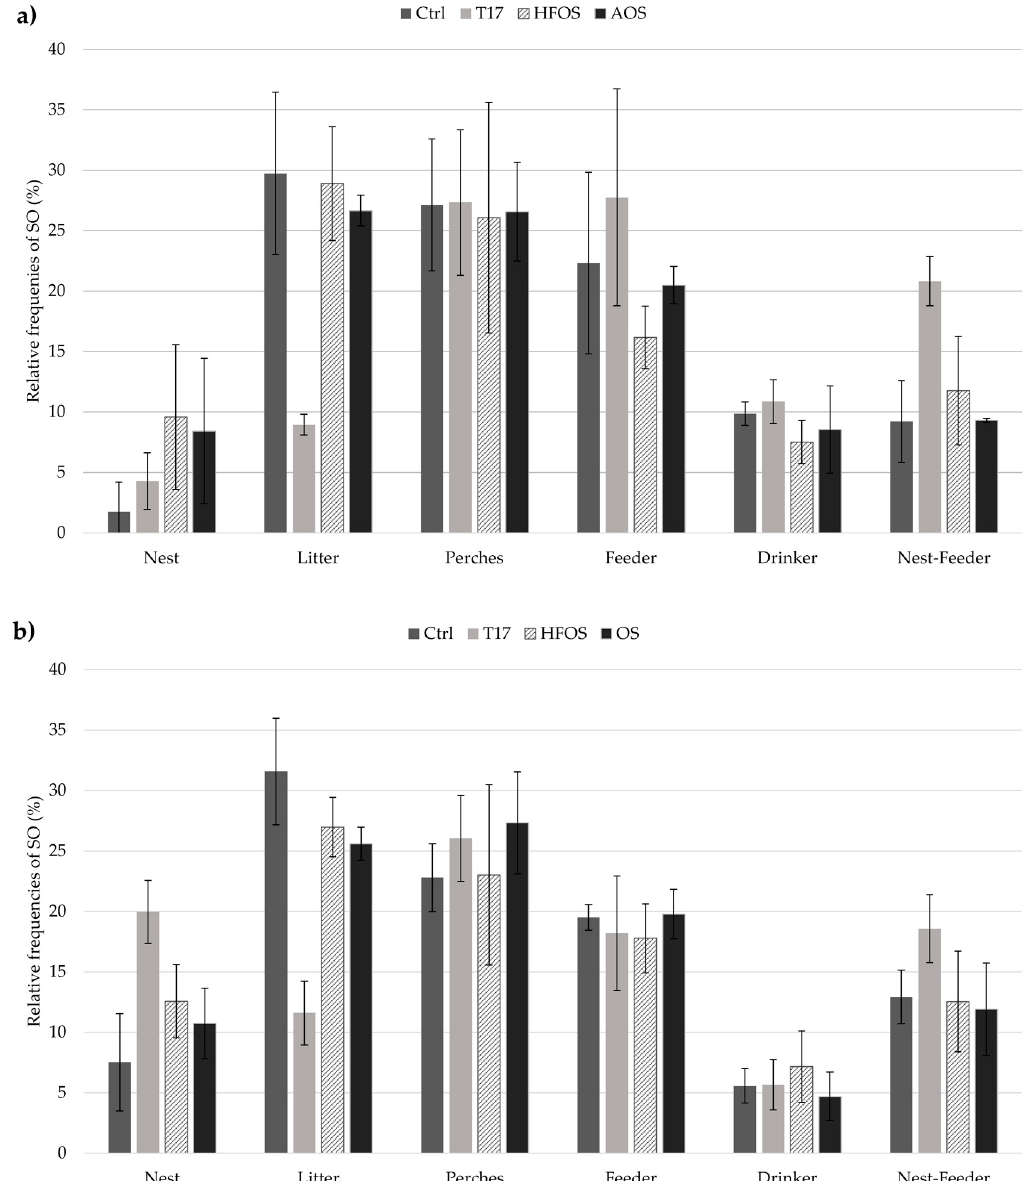
Figure 3. Relative frequencies of spatial occupancy (SO) with standard deviations from experimental cage-free system ( a ): Batch 1. ( b ): Batch 2. Ctrl = traditional aviary system. T17 = decrease of litter surface area. HFOS = use of heated floor with oil sprinkling periods. AOS = use of biochar material with oil sprinkling periods. OS = oil sprinkling periods.